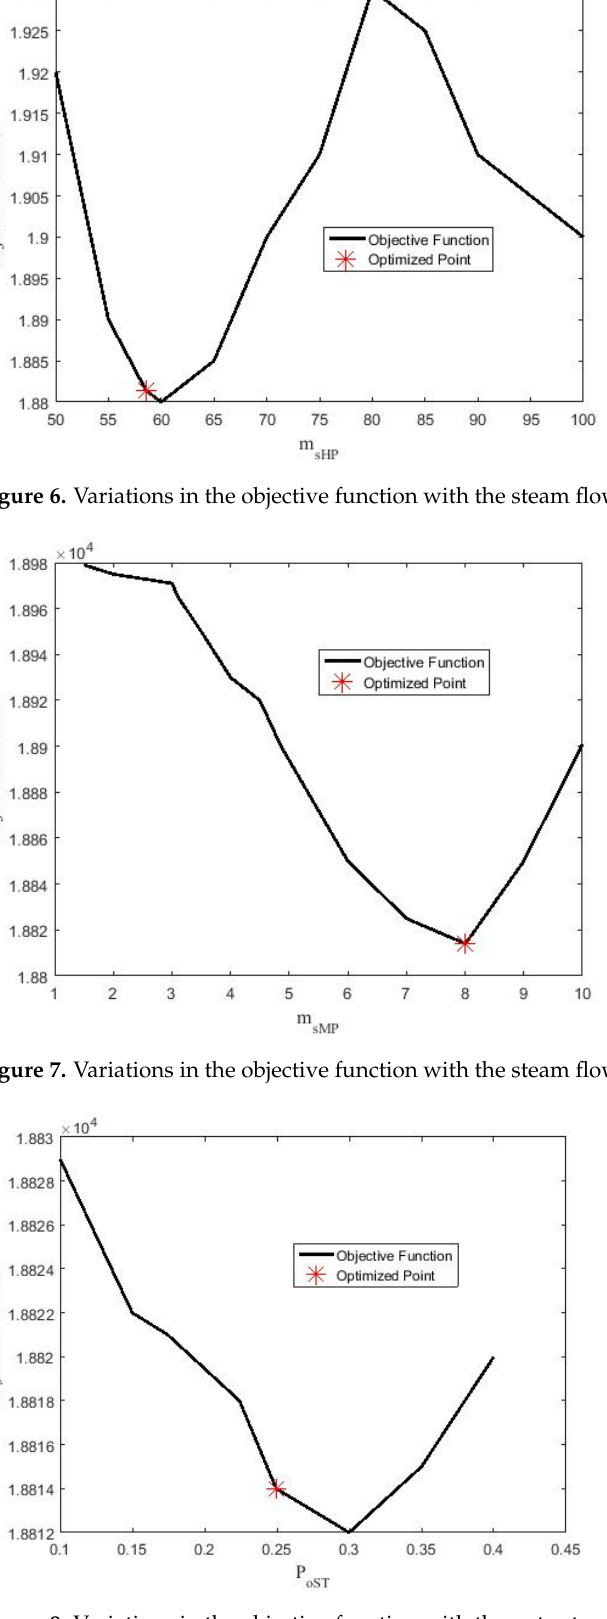
Figure 8. Variations in the objective function with the output pressure of the ST turbine.